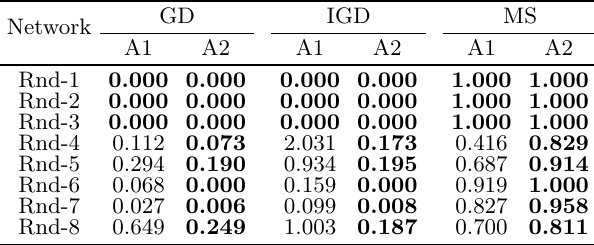
Table 1: Experimental results in terms of GD, IGD and MS (best results are in bold) GD IGD MS Network A1 A2 A1 Rnd-1 0.000 0.000